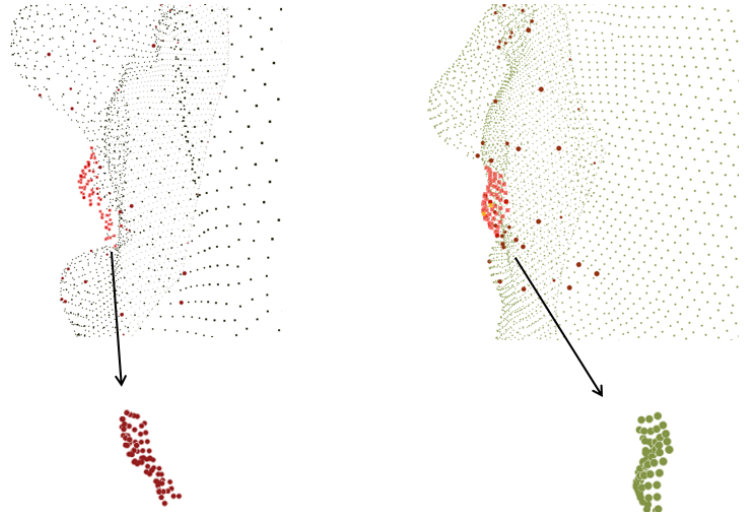
Figure 4. The left-hand image shows a part near the mouth of a sample from 3D-BUFE with an “Anger” expression; the red points are the neighborhood cluster origin at one of the landmarks. The right-hand image shows the same cluster from the same person with a “Happy” expression; a compound deformation can be observed within which the local rotation should not be simply